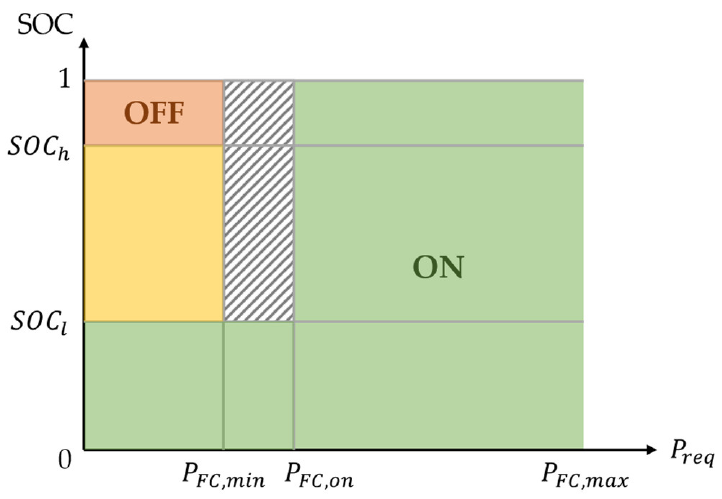
Figure 5. Baseline mode-based control strategy logic.